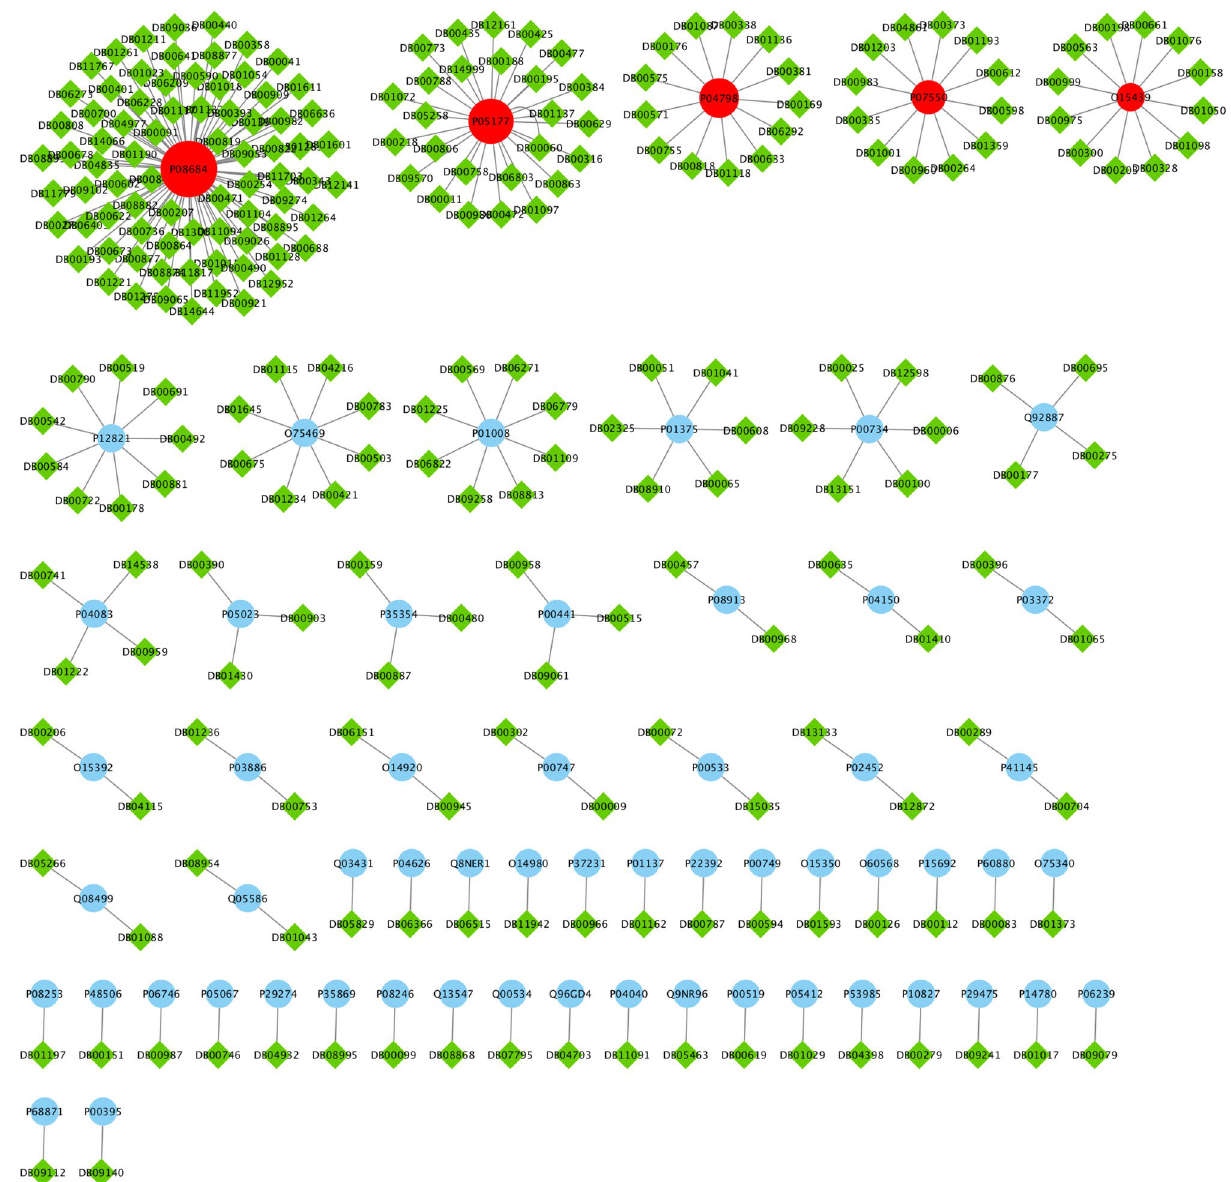
Figure 10. The drug targets in Clinical-Drug group that are located in C set.